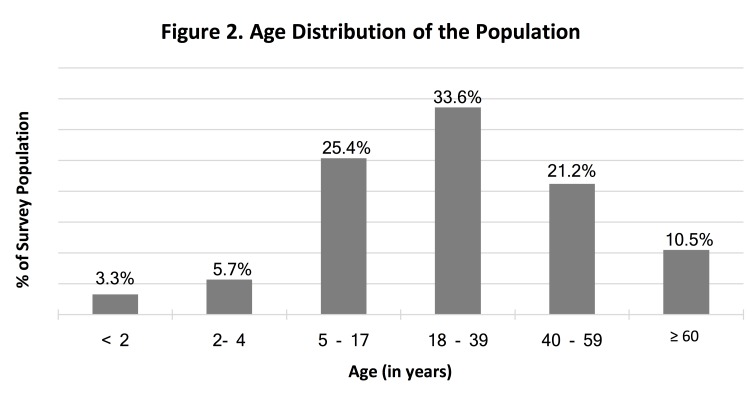
Figure 2. Age Distribution of the Population